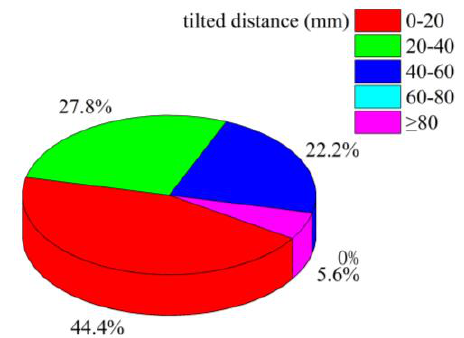
Figure 7. A 3D pie graph of the columns on the first floor